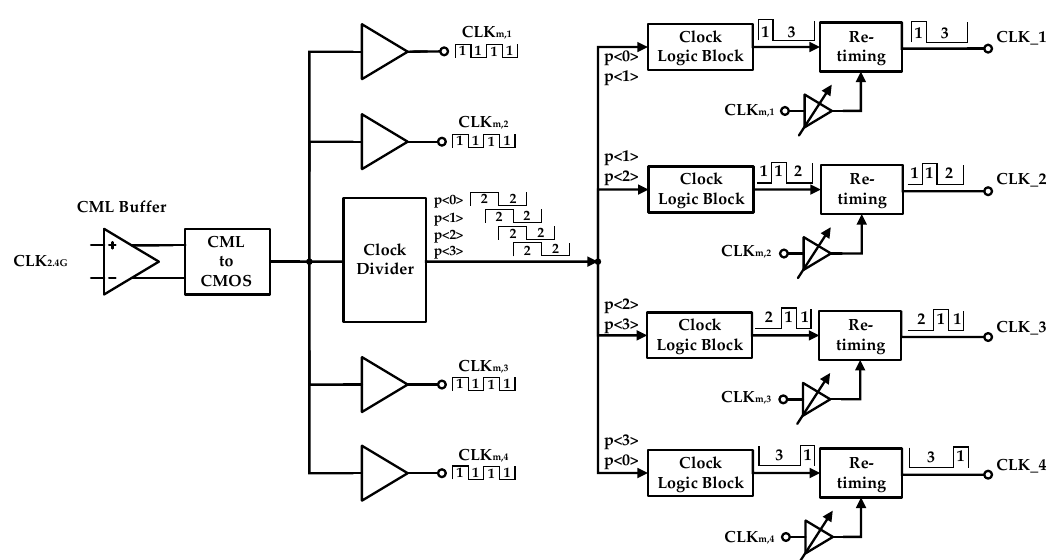
Figure 9. Specific clock scheme of the proposed 2.4 GS / s 12-bit ADC.